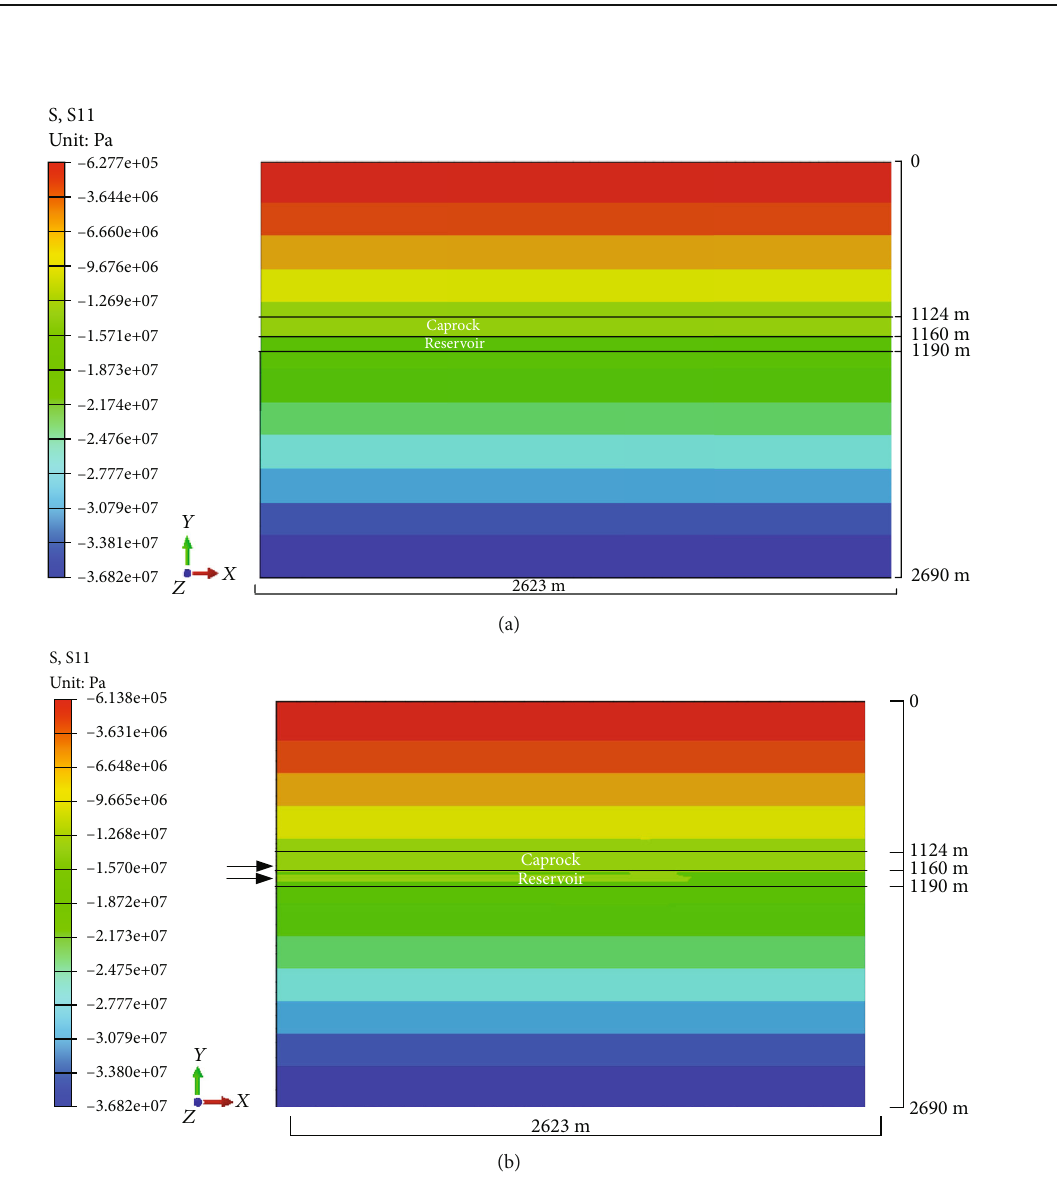
Figure 8: Horizontal stress nephogram. (a) Before injection. (b) After